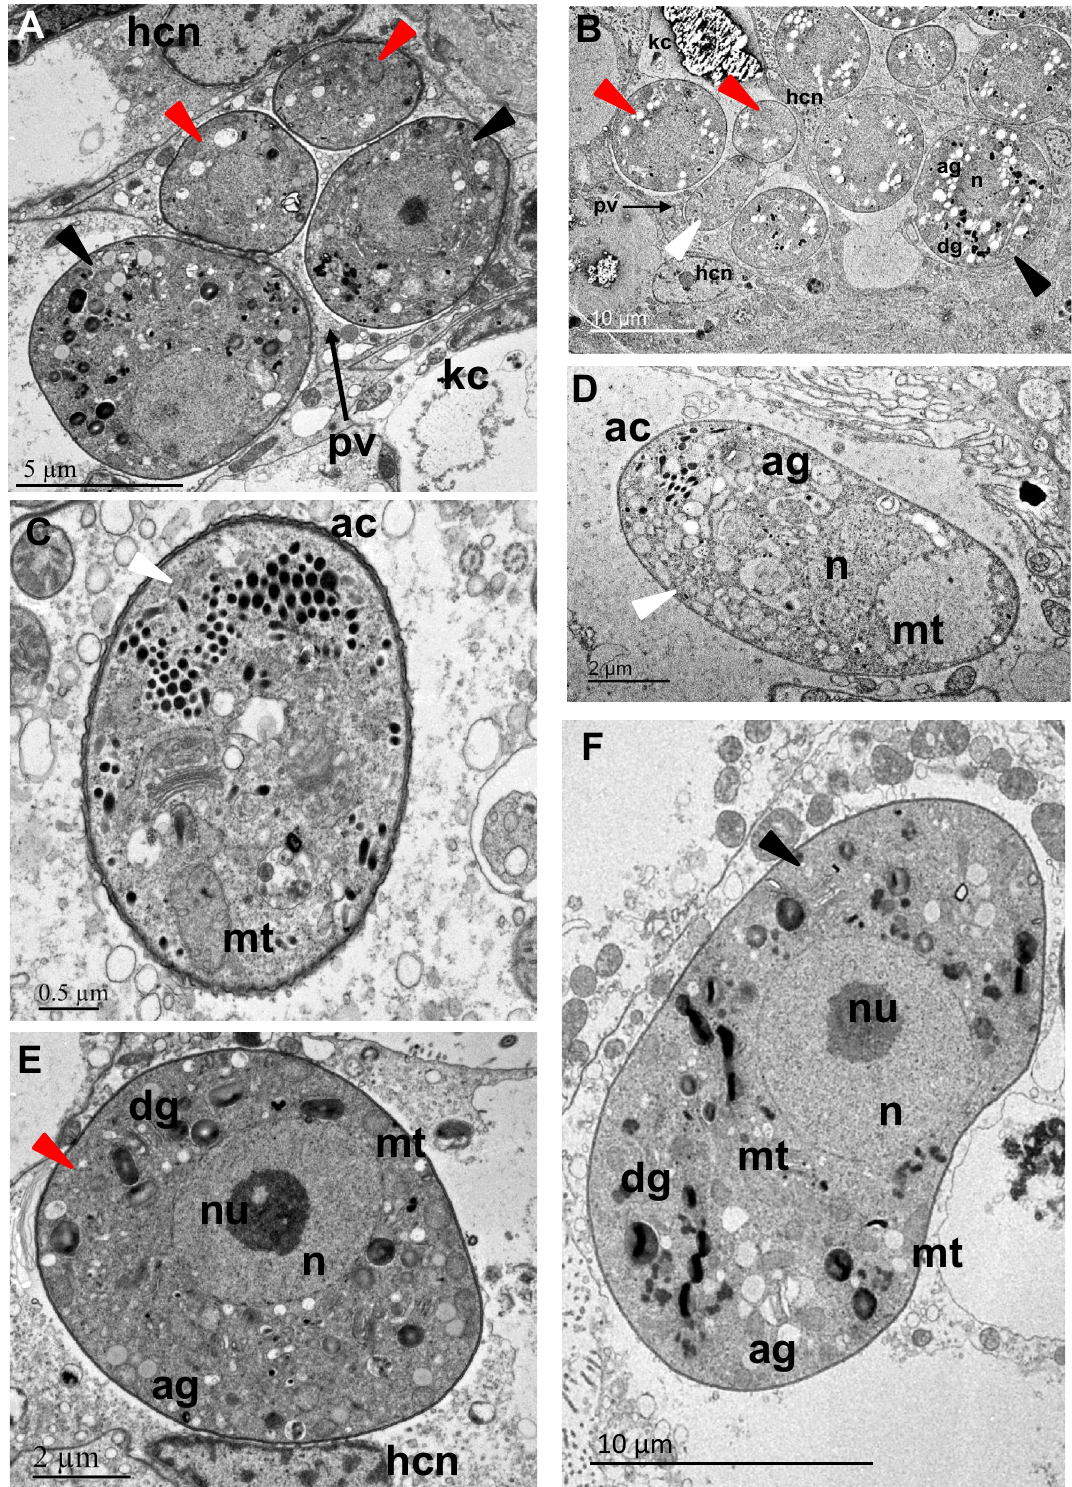
Figure 7. Ultrastructure of the most common BSM forms found in scallop kidney. ( A ) and ( B ): general views of kidney cells infected with multiple parasite cells. Different presumptive life stages are visible: early trophozoites (white arrowheads), growing trophozoites (red arrowheads) and gamonts (black arrowheads); ( C ) and ( D ): early trophozoites present an ellipsoidal form, contain a large mitochondrion (mt) posterior to the nucleus (n), and remnant components of the apical complex (ac), all hallmarks of the infectious sporozoite life stage that precedes the growing trophozoite stage; ( E ): a growing trophozoite presenting a round form and containing multiple vacuoles; ( F ): details of a macrogamont (sexual form) containing a large nucleus (n), several mitochondria (mt) and multiple granules. ag: amylopectin granule; dg: dense granule, hcn: host cell nucleus, kc: kidney concretion, pv: parasitophorous vacuole, nu: